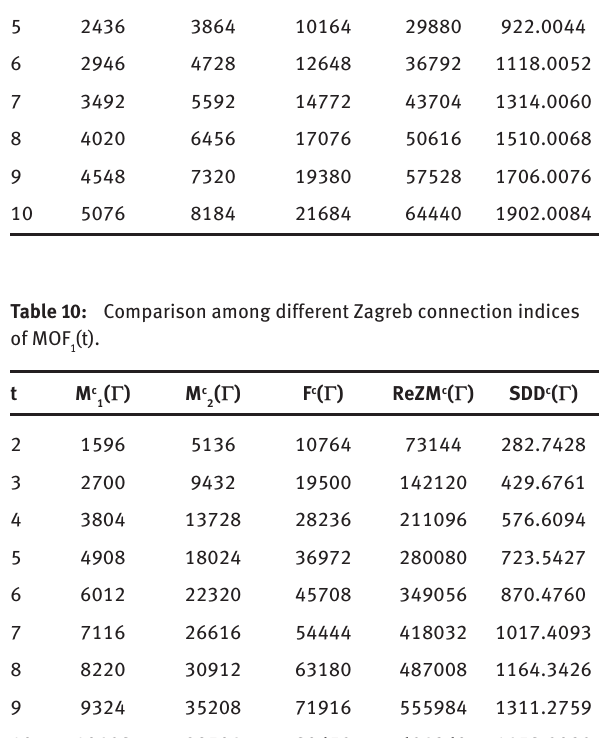
Table 11: Comparison among different Zagreb indices of MOF